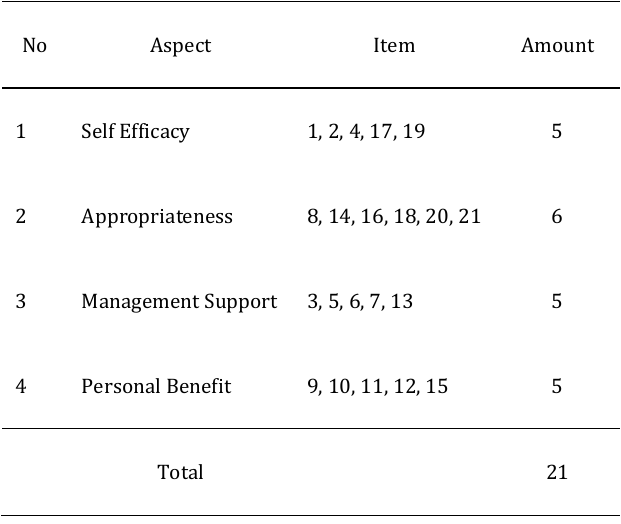
Table 1 The blueprint of the readiness for change